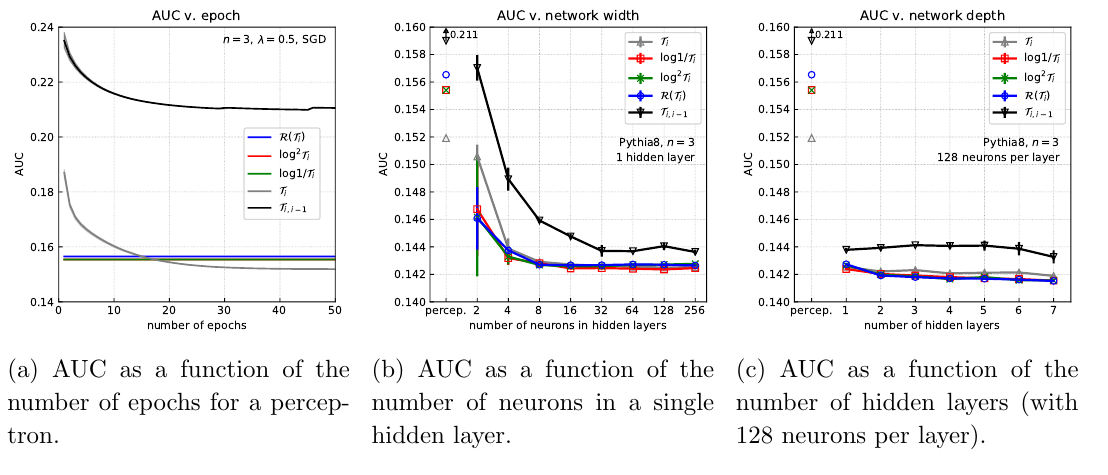
number of epochs for a percep- tron. Figure 7 . AUC convergence study for the Pythia8 sample as a function of the network parameters: number of training epochs, network width and network depth. The di(cid:11)erent inputs are represented with the same colours as in (cid:12)gure